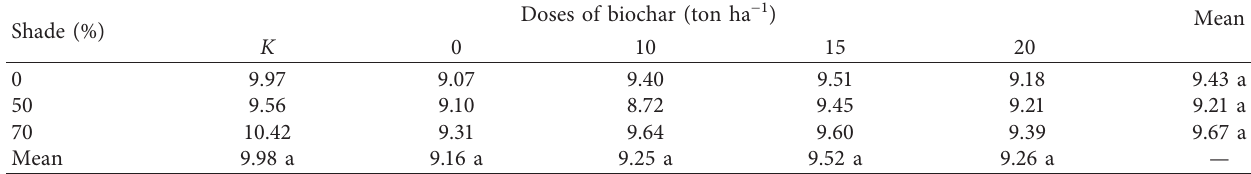
Table 5: Effects of biochar and shade application on the cation exchange capacity (cmol (+).kg − 1 ).